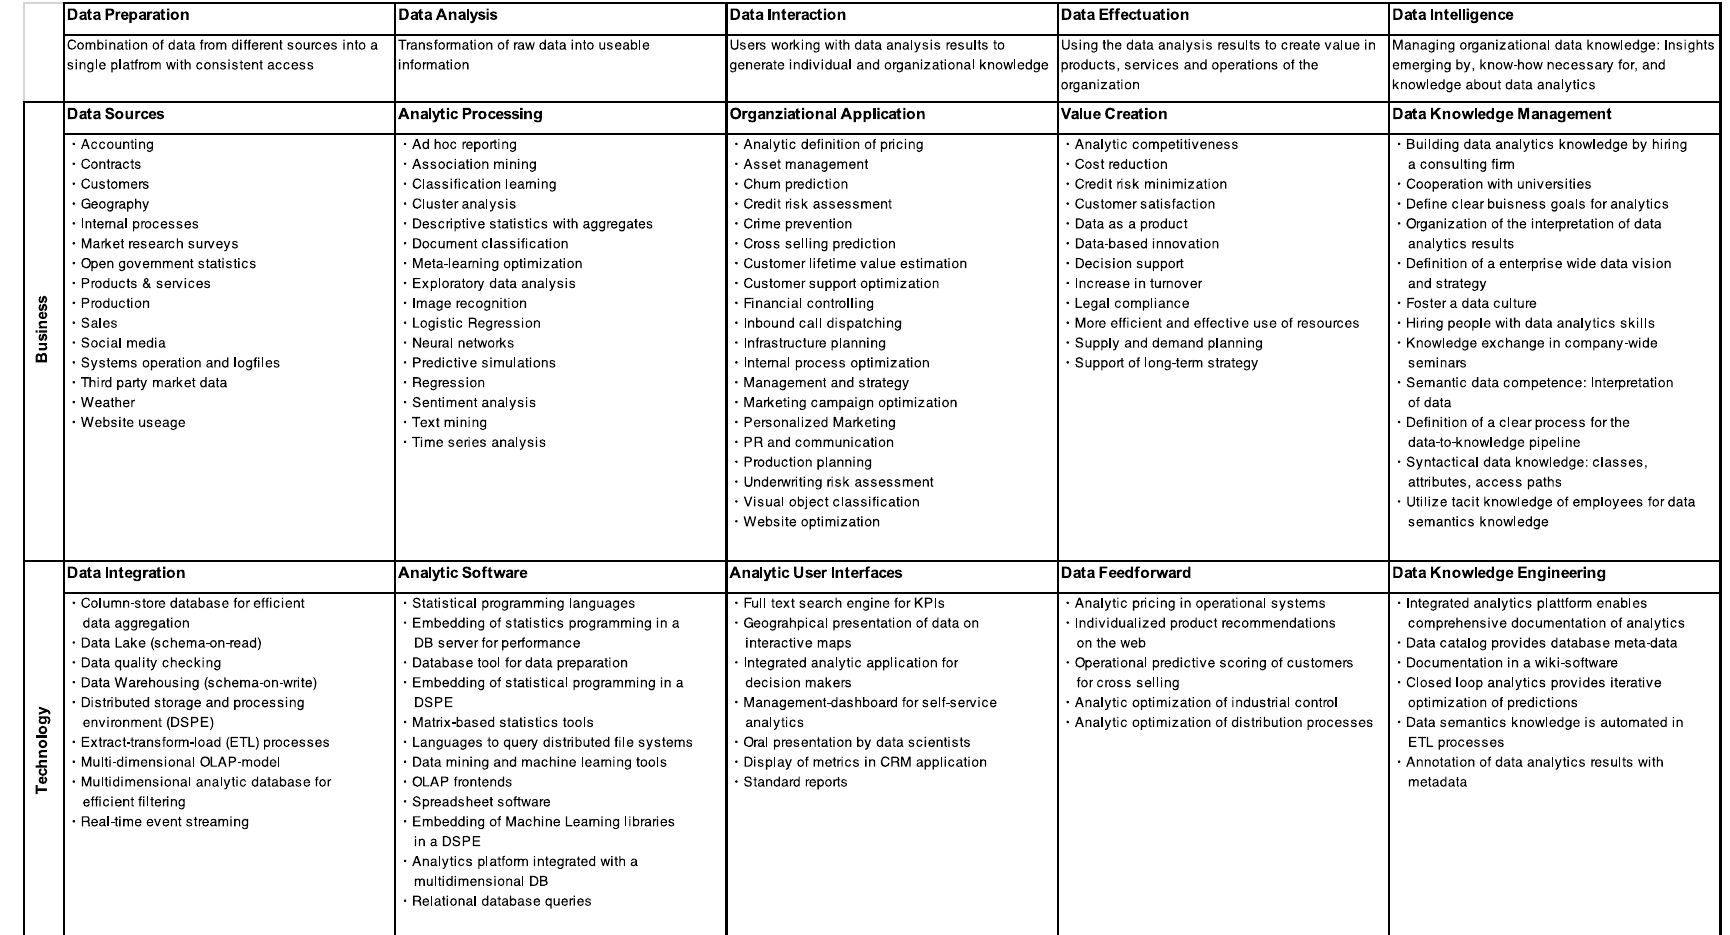
Figure 6. The proposed big data management reference model mapped to observations in three industry